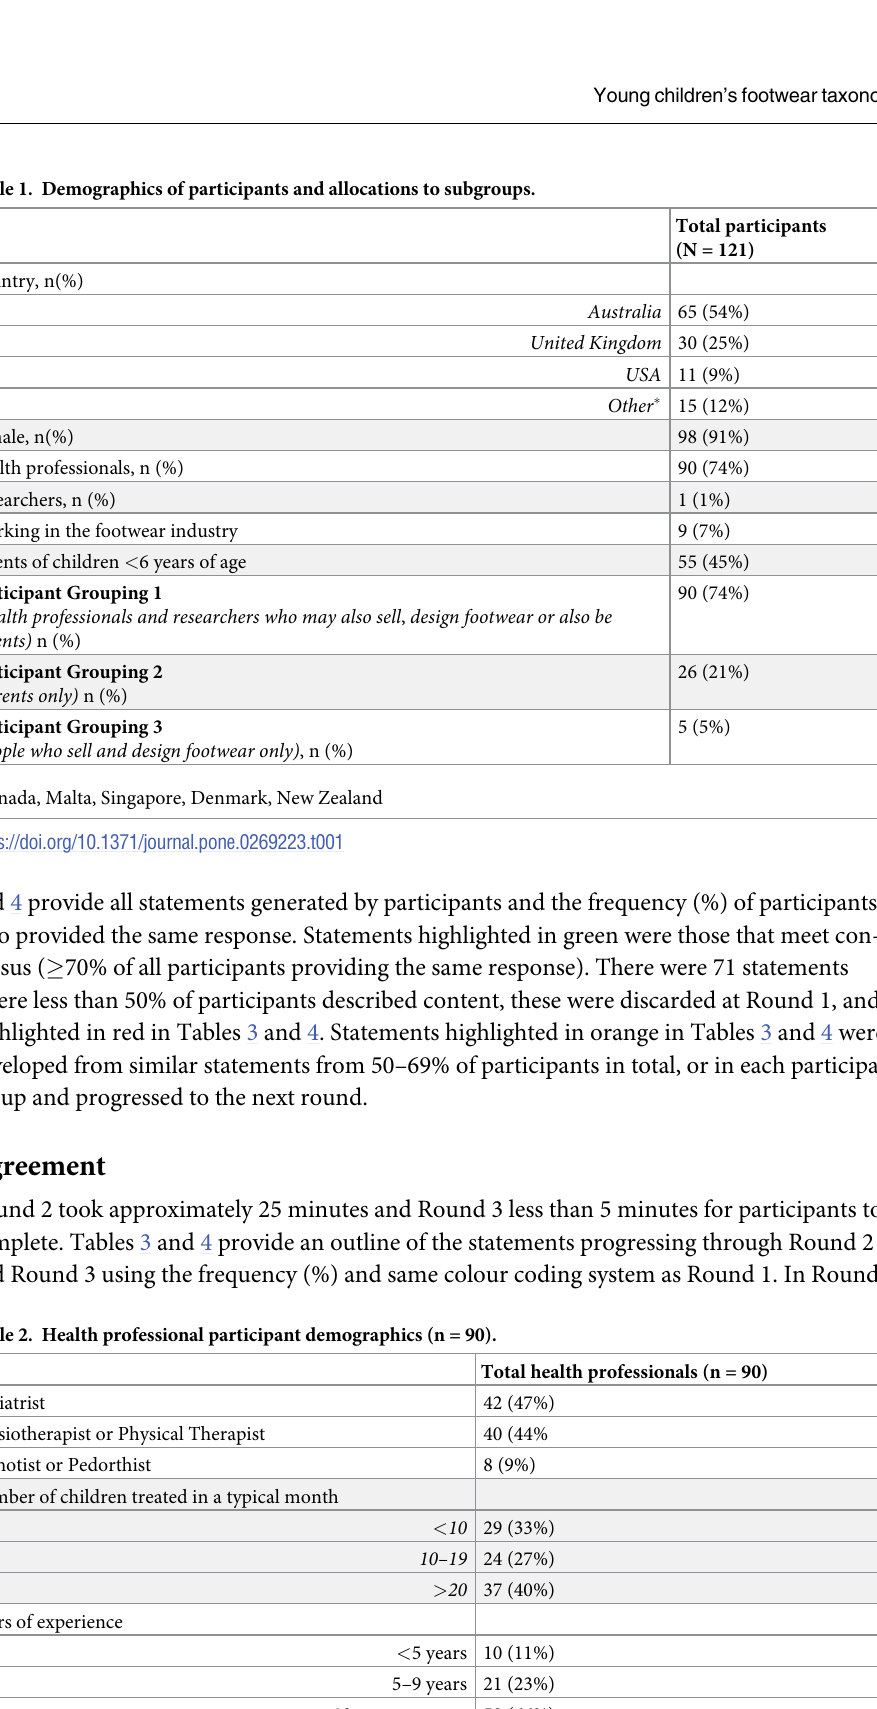
Table 1. Demographics of participants and allocations to